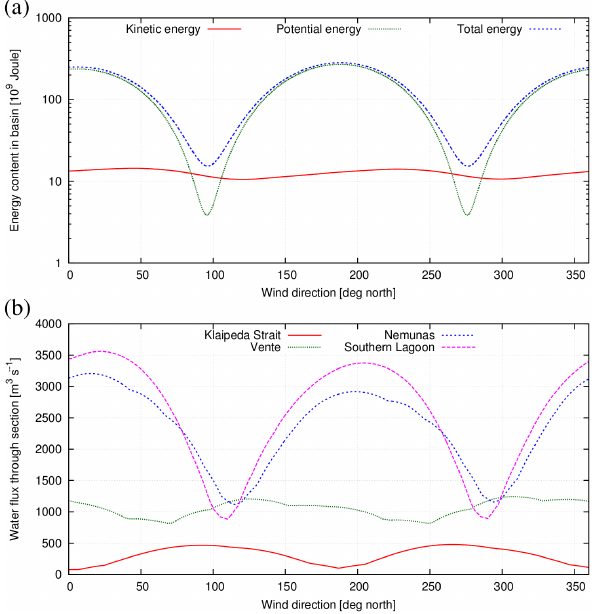
Figure 4. Energy content in basin (a) and fluxes through selected sections (b) depending on the Nemunas discharge. For the location of the sections see Fig.